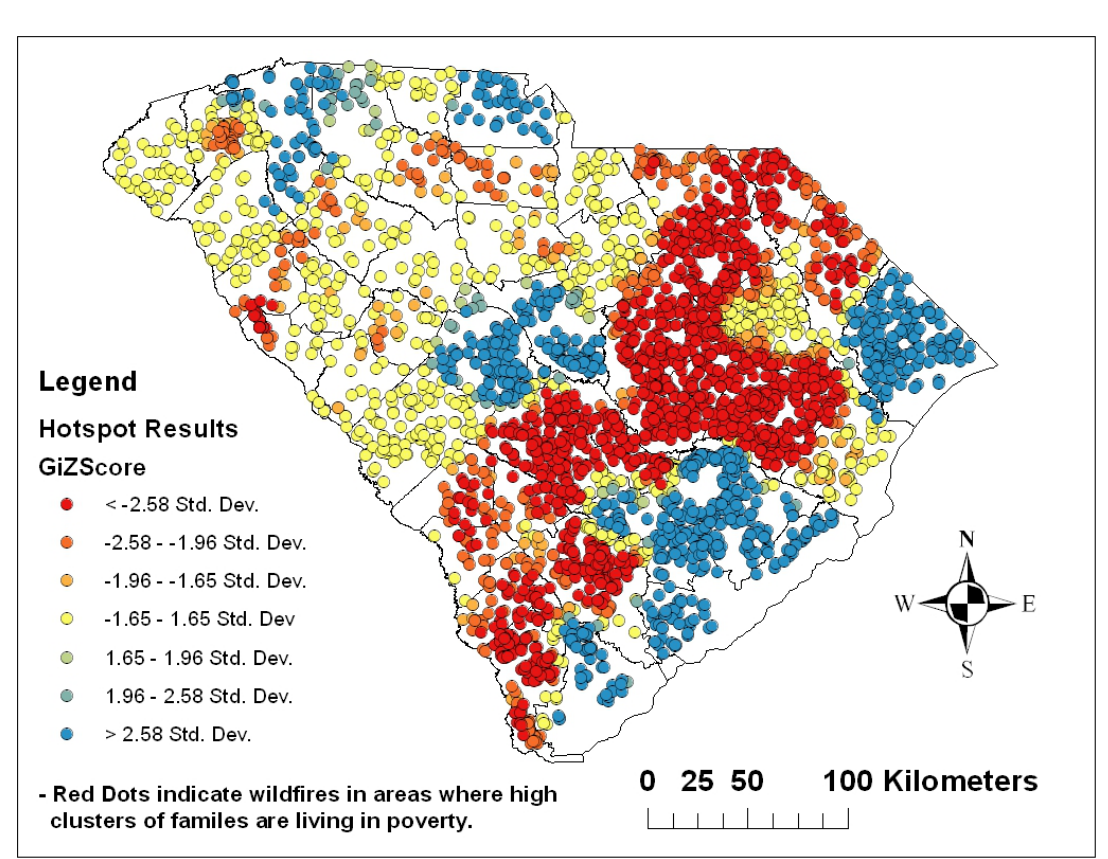
Figure 9. Hotspot analysis of poverty rates in South